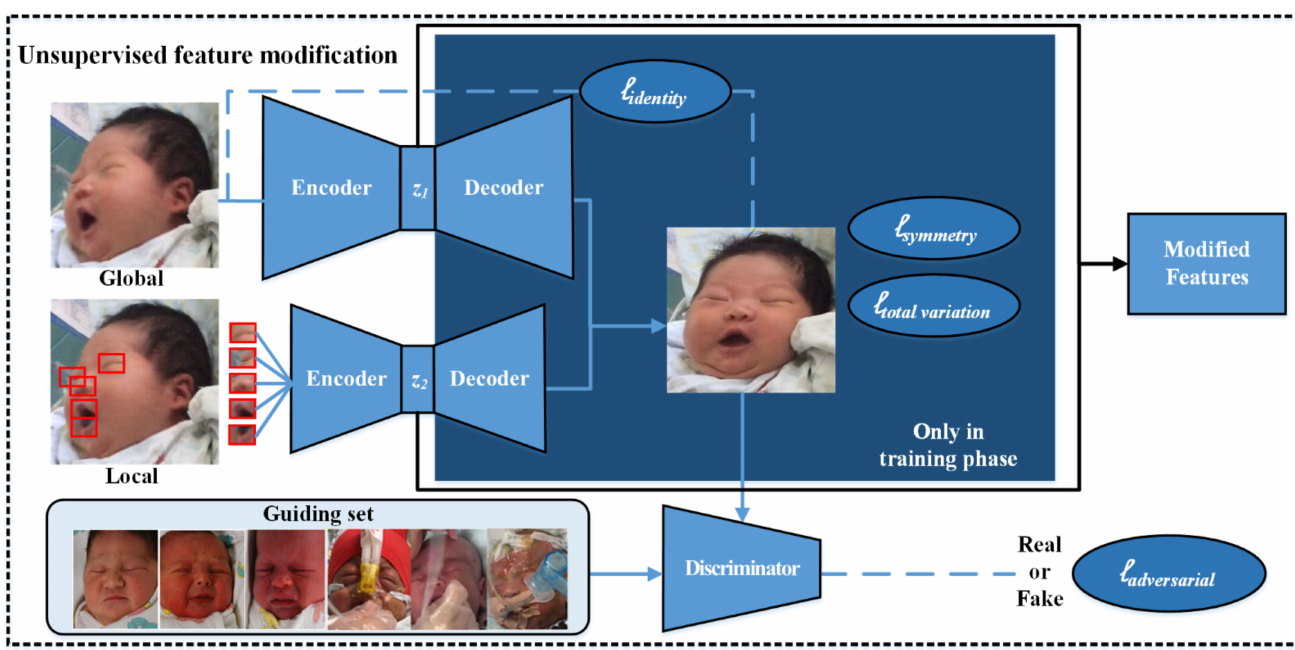
Figure 3. The framework of the unsupervised-feature-modification part in our AI-NPA